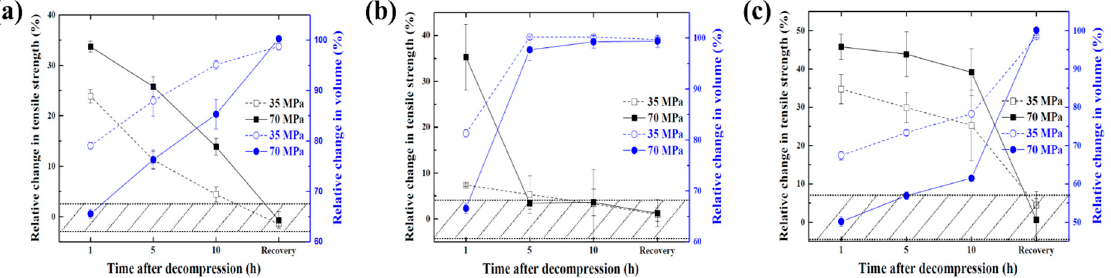
Figure 9. Relative change in tensile strength and volume over time after decompression. ( a ) NBR, ( b ) EPDM, ( c ) FKM.